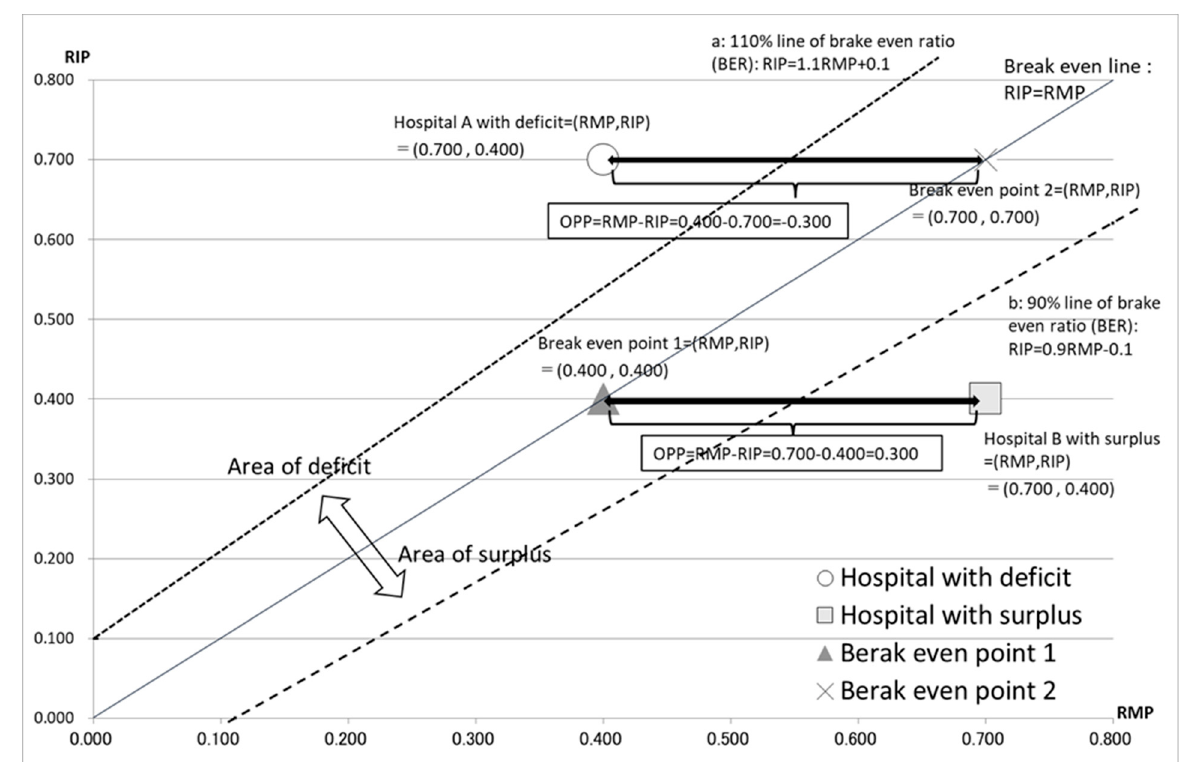
Figure 3. The relationship between RMP, RIP, OPP, and the break-even line. Hospital A, with a deficit, is shown as (RMP, RIP) = (0.400, 0.700). Hospital B, with a surplus, is shown as (RMP, RIP) = (0.700, 0.400). The line RIP = RMP is the break-even line. Line “a” represents 110% of the break-even ratio (BER): RIP = 1.1RMP + 0.1, calculated by the formula: RIP = BER (RMP + 1) − 1. Line “b” represents 90% of the BER: RIP = 0.9RMP − 0.1. The width between hospital A and BEP of 0.400 − 0.700 = − 0.300 shows the operating profit per USD 1 of personnel cost (OPP) of hospital A. The width between hospital B and BEP of 0.700 − 0.400 = 0.300 shows the operating profit per USD 1 of personnel cost (OPP) of hospital B. The area over the BER line is the deficit area and that below the BER line is the surplus